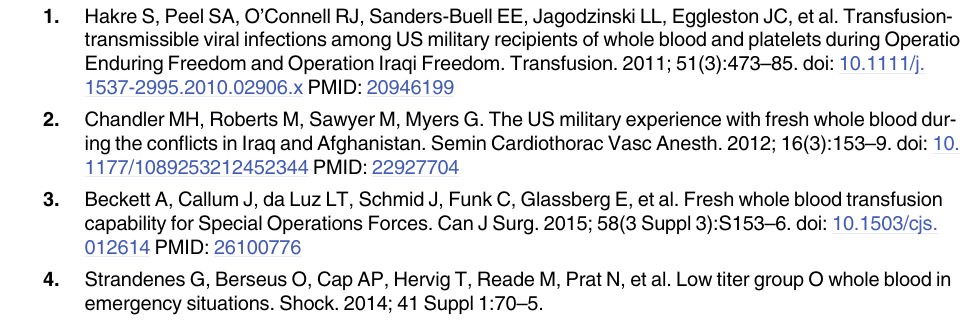
S5 Table. Survivors; length of stay at MBTK and destination after treatment. MBTK